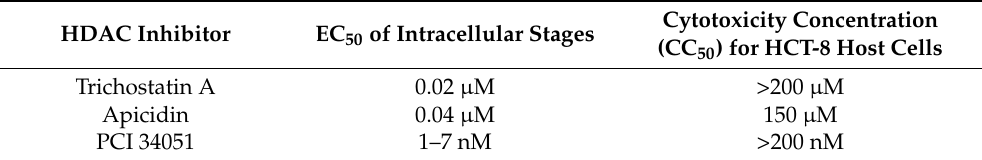
Table 3. Effects of HDAC inhibitors on infected HCT-8 cells. EC 50 and CC 50 of HCT-8 cells infected and treated with different HDAC inhibitors .